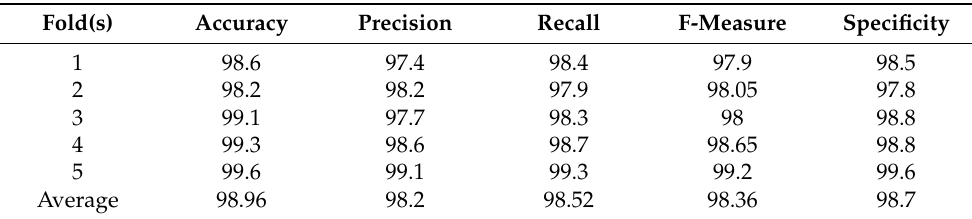
Table 4 denotes the cross-validation outcome for dataset_2. Table 3. Performance analysis of PCNN model for dataset_1.